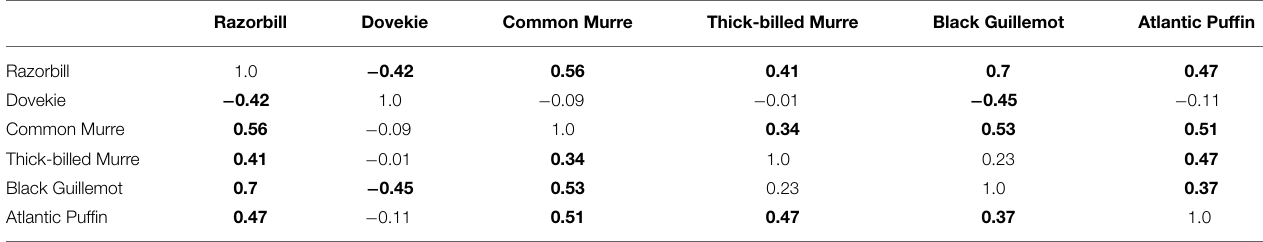
TABLE 2 | Spearman rank correlation coefficients of abundance among species. Razorbill Dovekie Common Murre Thick-billed Murre Black